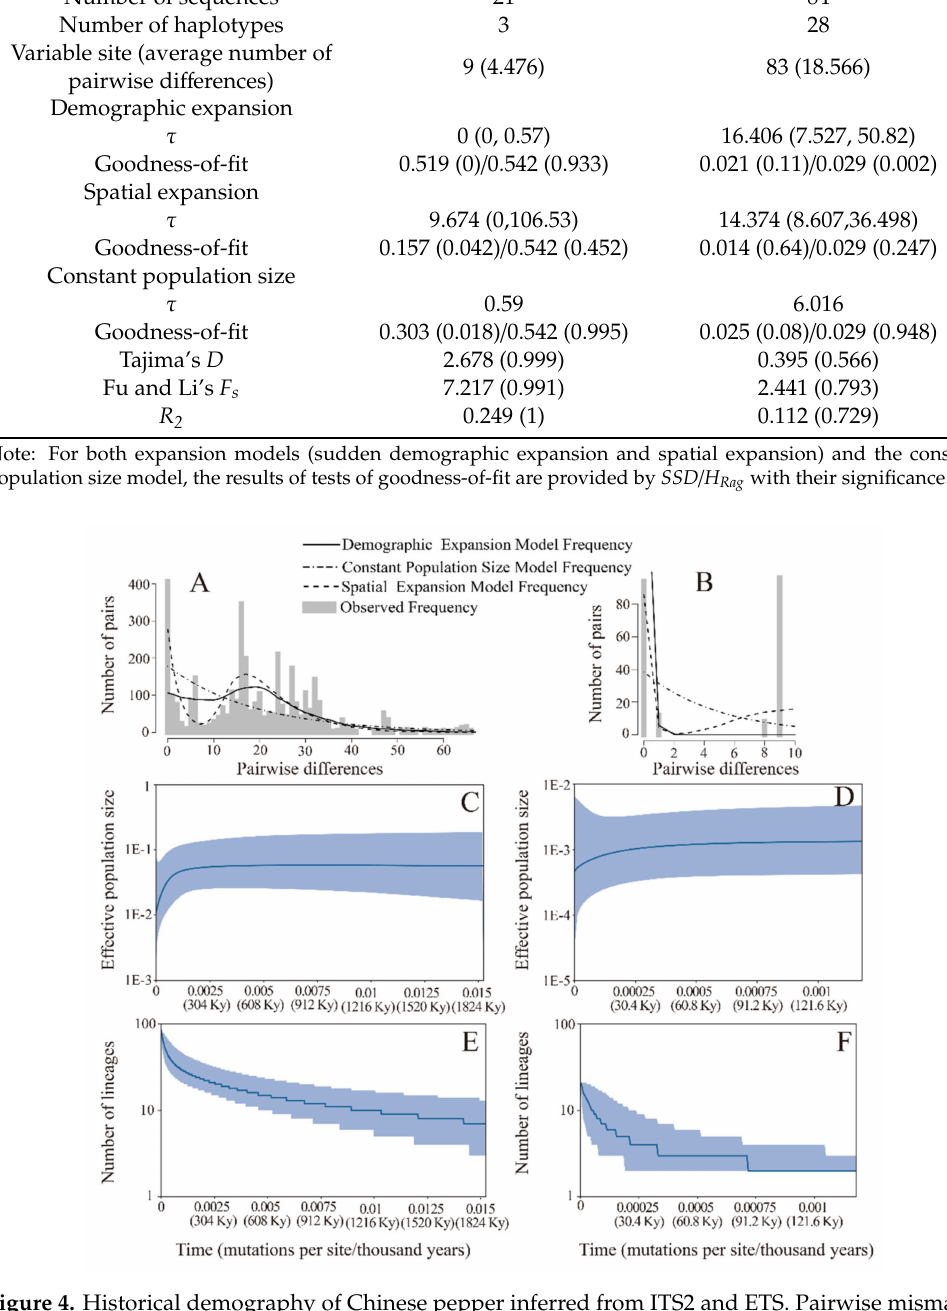
Figure 4. Historical demography of Chinese pepper inferred from ITS2 and ETS. Pairwise mismatch distributions for Z. bungeanum ( A ) and Z. armatum ( B ). Bayesian skyline plots for Z. bungeanum ( C ) and Z. armatum ( D ), showing e ff ective population size as a function of time. The upper and lower limits of royal blue trend represent the 95% confidence intervals. Lineages through time plot for Z. bungeanum ( E ) and Z. armatum ( F ), showing the same pattern of